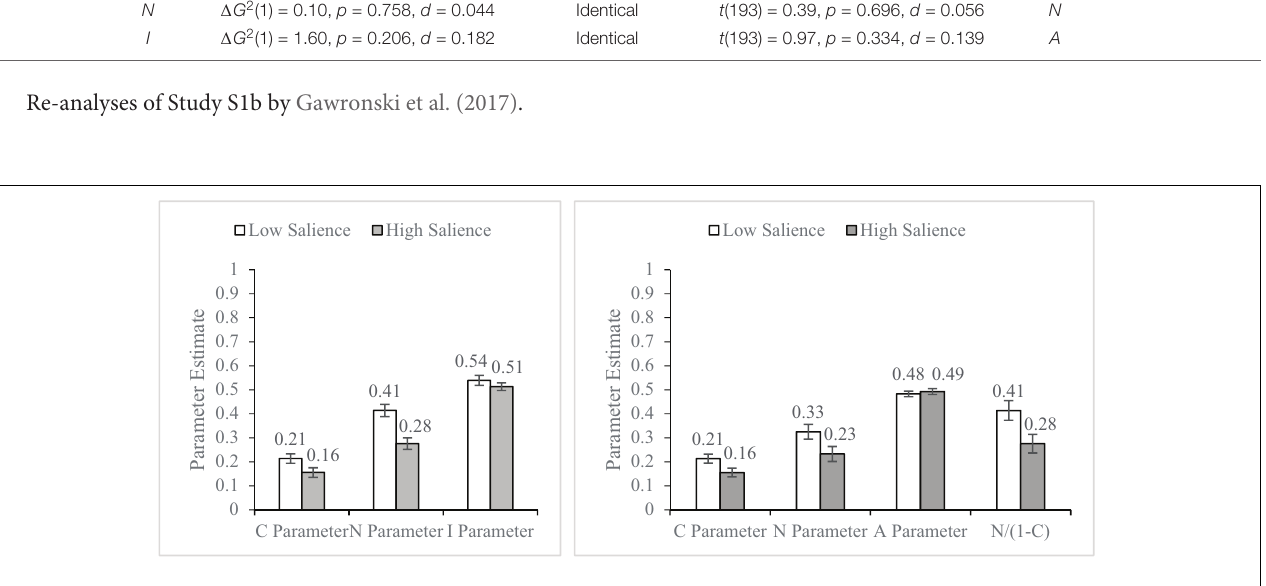
Frontiers in Psychology |